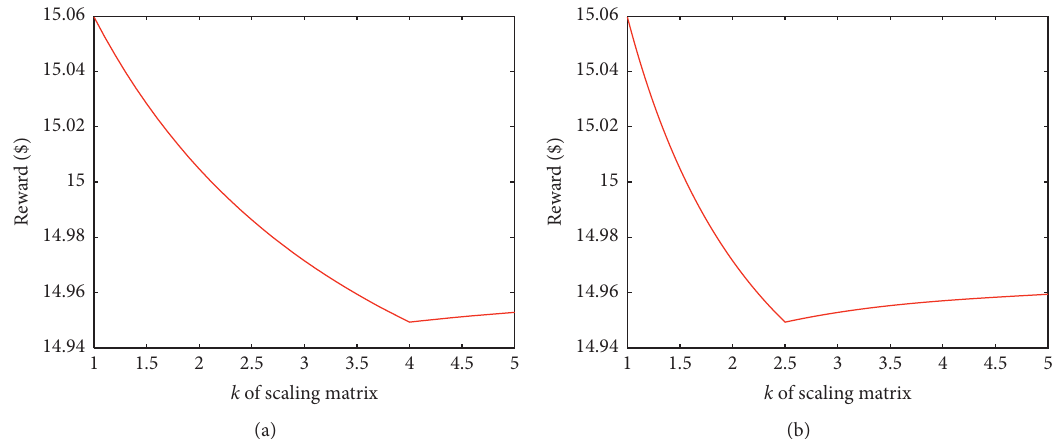
Figure 1: Rewards over different A in model (47). (a) Rewards over scaling matrices A